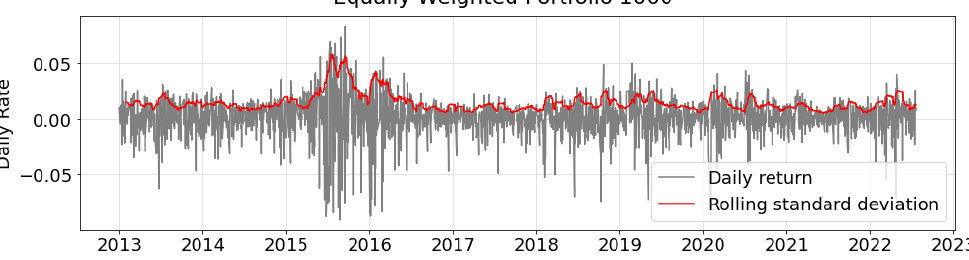
Figure A1. Out-of-sample Return Performance of the equally weighted 1000 investment portfolio. The gray line denotes the daily rate of return and the red line denotes a moving window standard deviation of 20 daily returns.